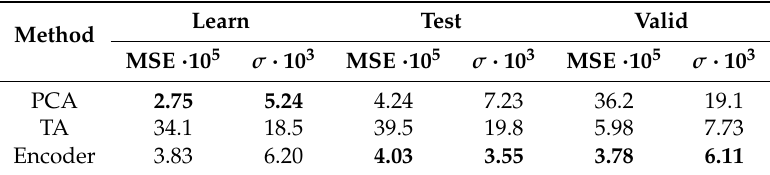
Table 3. Comparison of the learning, testing, and validation errors: P3.